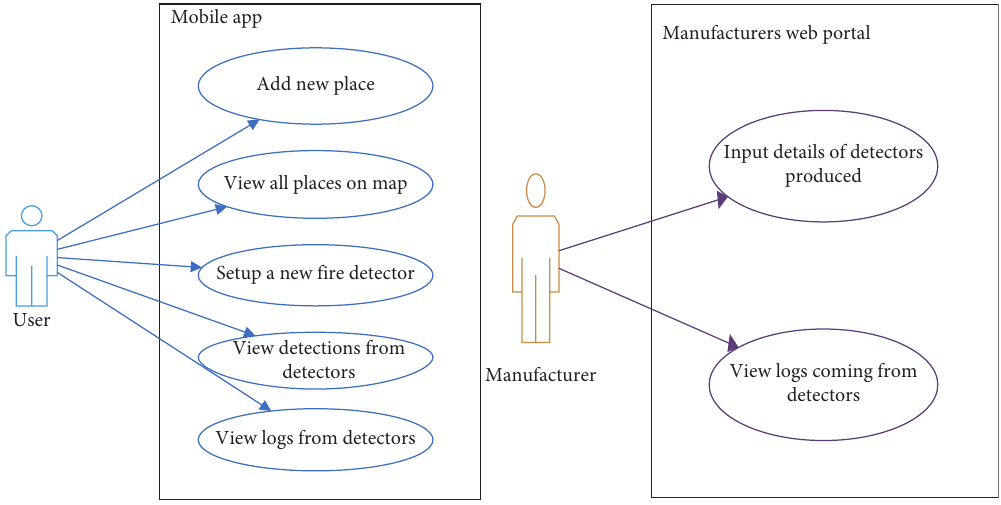
Figure 9: Mobile application use case there is an incidence of a fire or otherwise; the classes for The field tests performed for the different components classification are “fire” and “no fire.” Figures 15(a) and 15(b) show the results obtained from test instances of fire and no fire situations, respectively. The test cases used considered The video classification task for the system’s use case is a the occurrence of fire both indoors and outdoors from the basic binary classification task. The system indicates whether